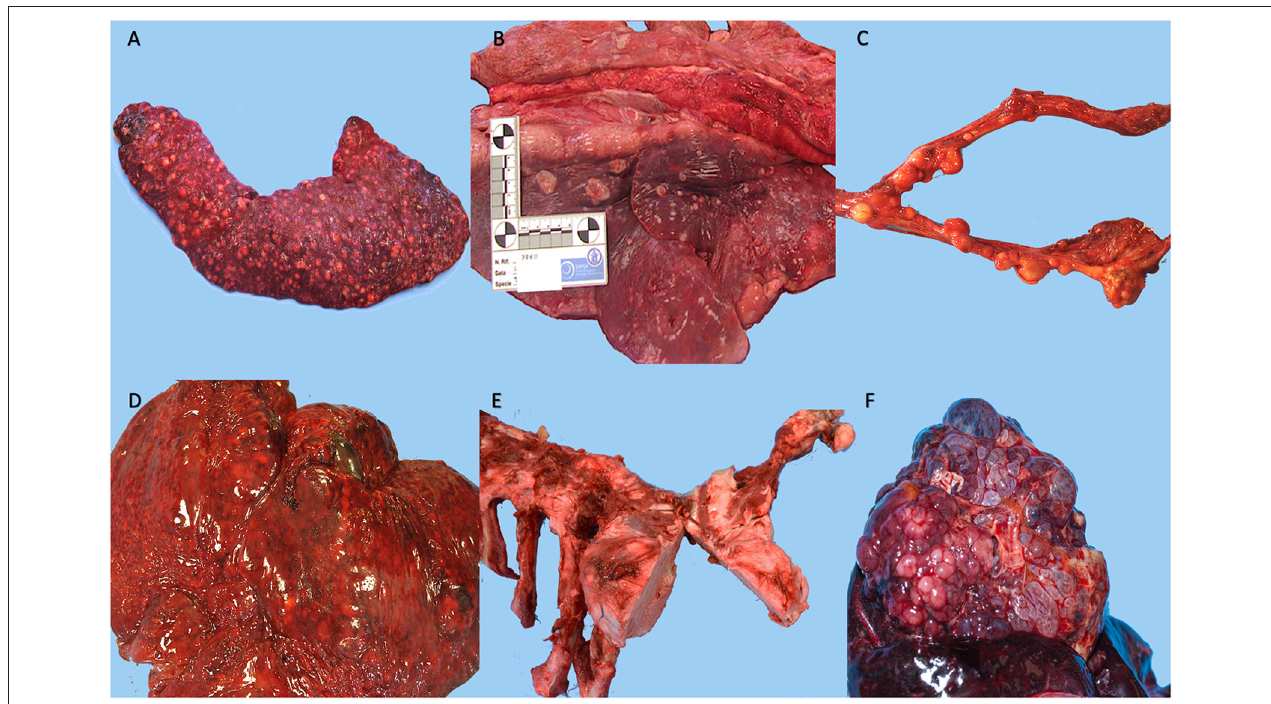
FIGURE 3 | Representative histological section of tumors observed in our study. (A) Esophagus, leiomyosarcoma, neoplasm was composed of spindle-shaped cells arranged in streams, with brightly eosinophilic cytoplasm and oval nuclei (hematoxylin and eosin, 20x), Tiger (Panthera tigris), (B) Lung, metastasis of leiomyosarcoma, expanding the pulmonary parenchyma (inset) there is a nodule composed of spindle-shaped cells arranged in streams, with brightly eosinophilic cytoplasm and oval nuclei (hematoxylin and eosin, 10x and 20x), Tiger (Panthera tigris), (C) Rib, osteoma, neoplasm was composed of broad, interconnected bony trabeculae with central cores of woven bone surrounded by lamellar bone; intertrabecular spaces were filled with sparse spindle cells (hematoxylin and eosin, 4x), Tiger ( Panthera tigris ), (D) Thyroid, thyroid carcinoma, tumor cells were arranged in poorly-formed, variably-sized follicles filled with pale eosinophilic homogenous material (colloid), packets and solidly-cellular areas supported by a fine fibrovascular stroma. Areas of necrosis were observed, (hematoxylin and eosin, 20x) Tiger (Panthera tigris), (E) Soft palate, oral squamous cell carcinoma, neoplasm was composed of various sizes island and fronds of squamous cells with acid cytoplasm, pleomorphic and vesicular nuclei with prominent nucleoli, (hematoxylin and eosin, 20x), Tiger (Panthera tigris), (F) Liver, cholangiocarcinoma, neoplasm was composed of small, irregular, gland-like structures or packets of neoplastic cells embedded in connective tissue stroma. Cells had a moderate amount of clear to pale eosinophilic, round to oval and hyperchromatic nuclei with prominent nucleoli, (hematoxylin and eosin, 20x), Lion ( Panthera leo